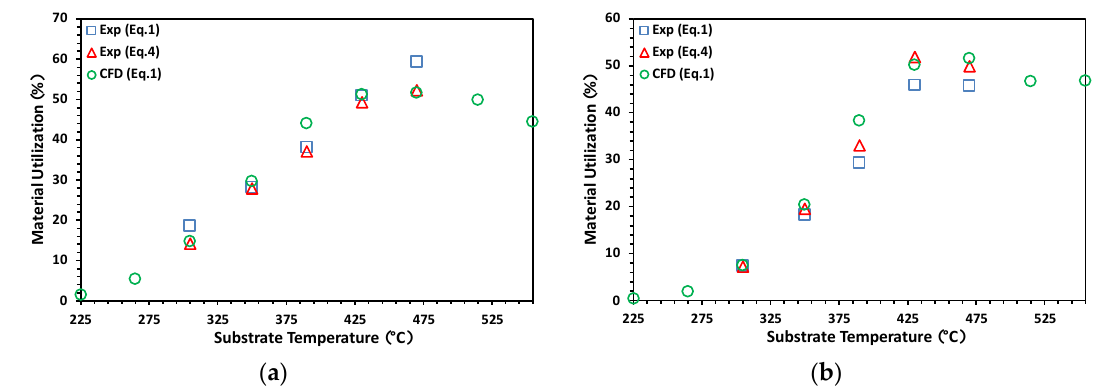
Figure 10. Experimental and numerical comparison of material utilisation as a function of T s for ( a ) F total = 0.5 l/min and ( b ) F total = 1.0 l/min.